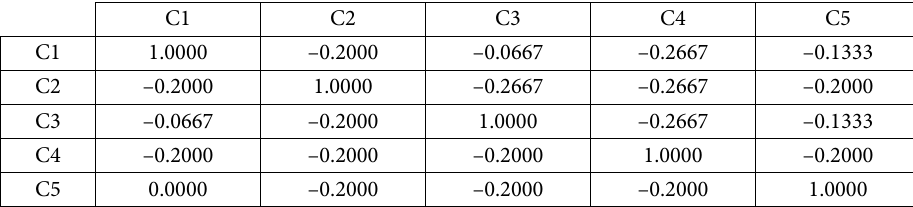
Table 10. Matrix I – X for inter-cluster relationships